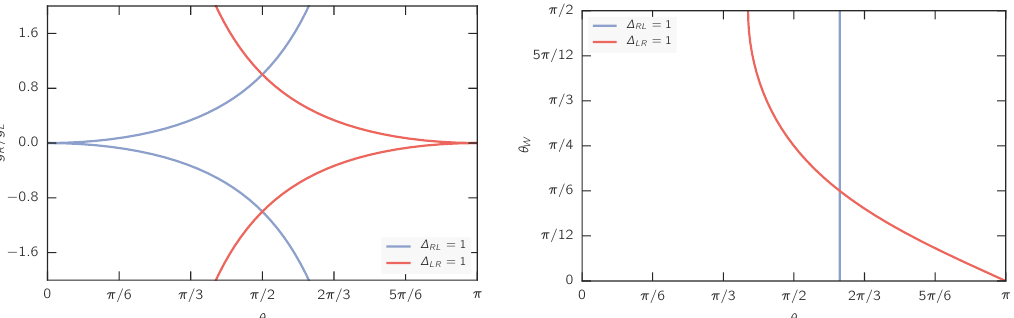
Figure 3: Left: Maximal concurrence line as a function of the scattering angle θ and the coupling / g ratio g for Z -mediated e − e + → µ − µ + scattering. Blue line: electron and positron with right- and R L left-handed initial helicities respectively; red line: electron and positron with left- and right-handed initial helicities. Maximal entanglement is achieved at the same scattering angle θ for the two initial helicity configurations when the coupling ratio is equal to one, which leads to a Weinberg angle of π/ 6. Right: Maximum concurrence line for the weak mixing angle θ as a function of scattering angle θ for W the process e − e + → µ − µ + , now including also the effects of Z /γ interference. Imposing that MaxEnt is = π/ achieved for the same value of the scattering angle θ fixes θ W